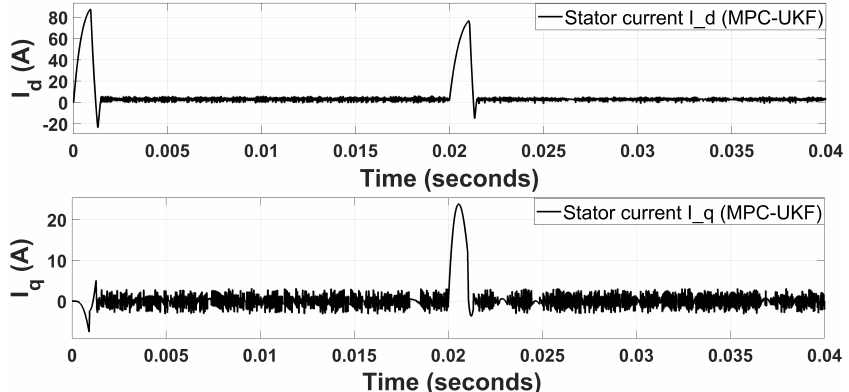
Figure 6. dq -reference stator currents for